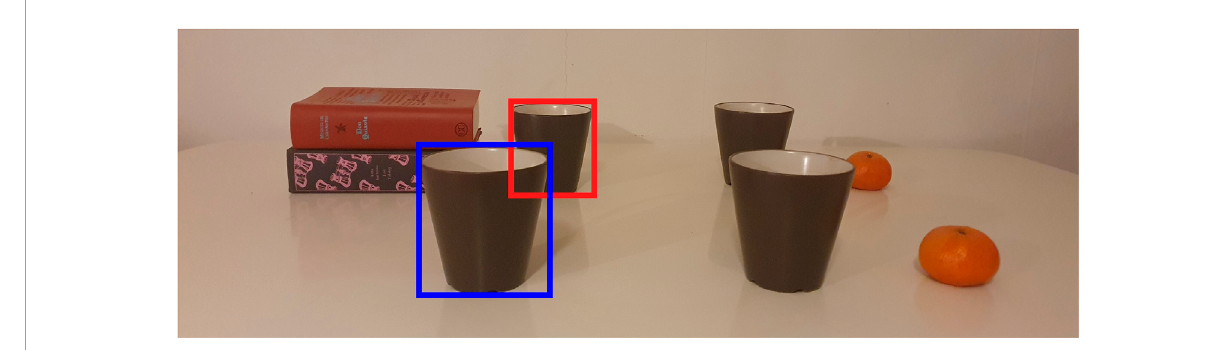
FIGURE 1 An example illustrating the motivation behind using depth to improve referring expression comprehension. In this example, when the user’s object description is ‘the mug next to the books’, the robot can suggest the mug in the blue bounding box in RGB or the one in the red bounding box in RGB-D. Best viewed in color.